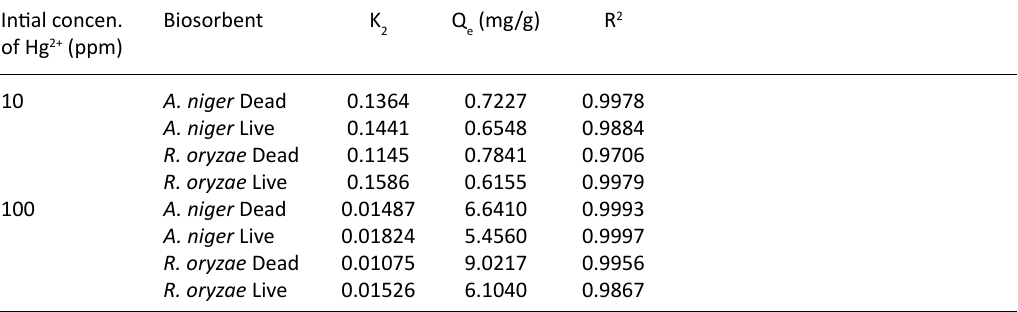
Table 3. Parameters of biosorption model isotherms for Hg 2+ at low (10 ppm) and high concentration (100 ppm) Concentration Isotherm Parameters